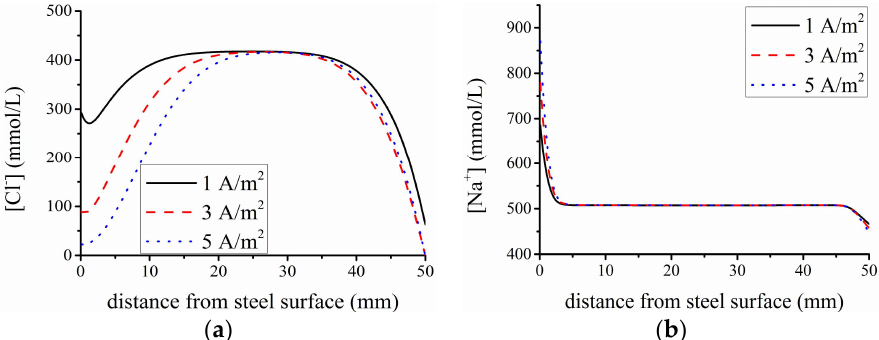
Figure 4. The concentration profiles of cations and anions within the concrete cover after 1, 3, and 5 A/m 2 of the electrochemical treatment ( a ) Cl − ; ( b ) Na + .